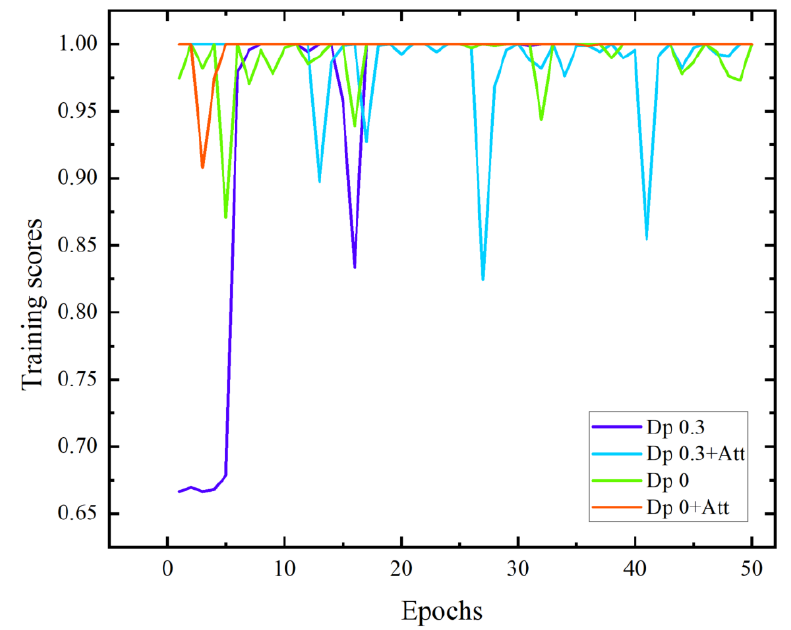
Figure 13. Test data training score curves of the four models.